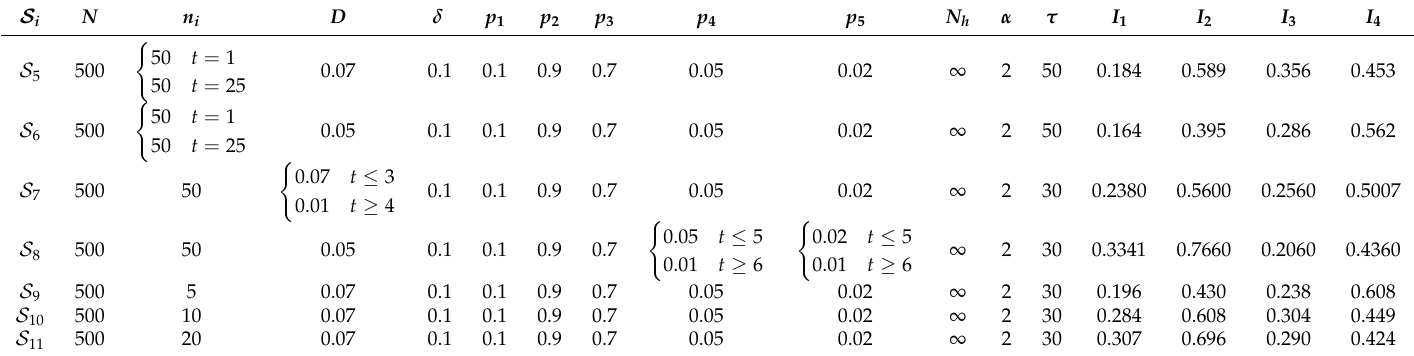
Table 2. Numerical values of the EED parameters for scenarios S i , i = 5, . . . ,11, and the cost indices I j , j = 1, . . .